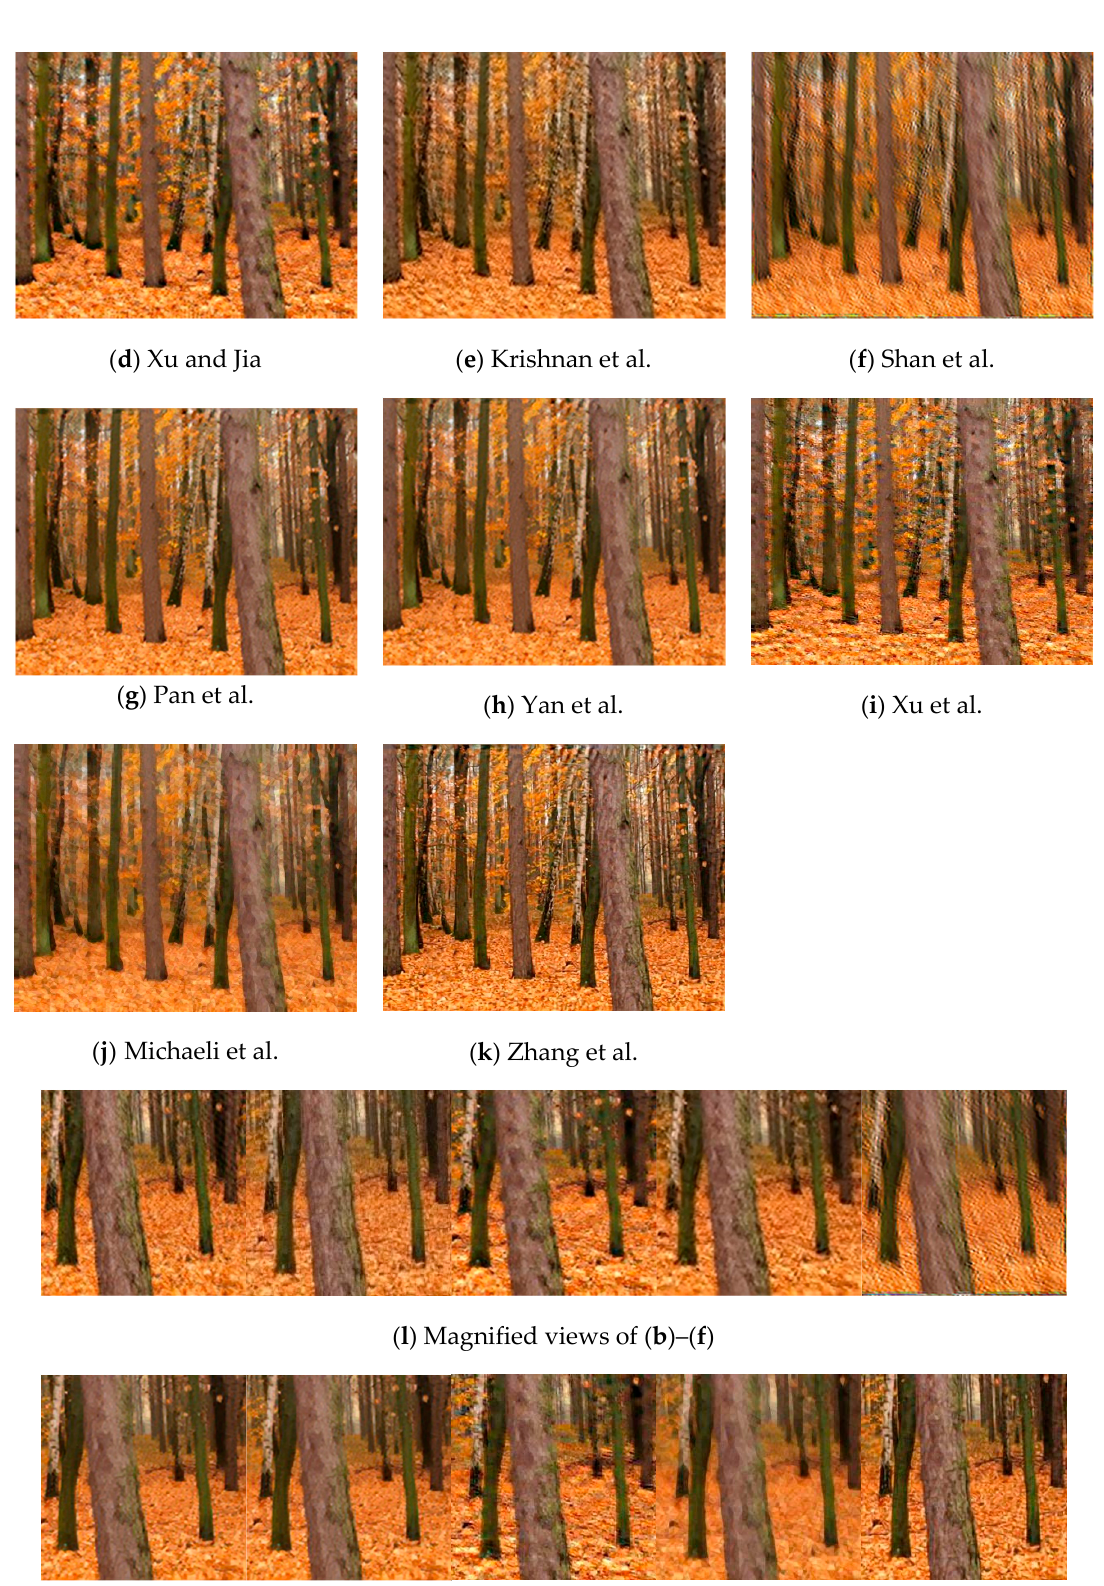
Figure 12. Image deblurring results of standing trees.